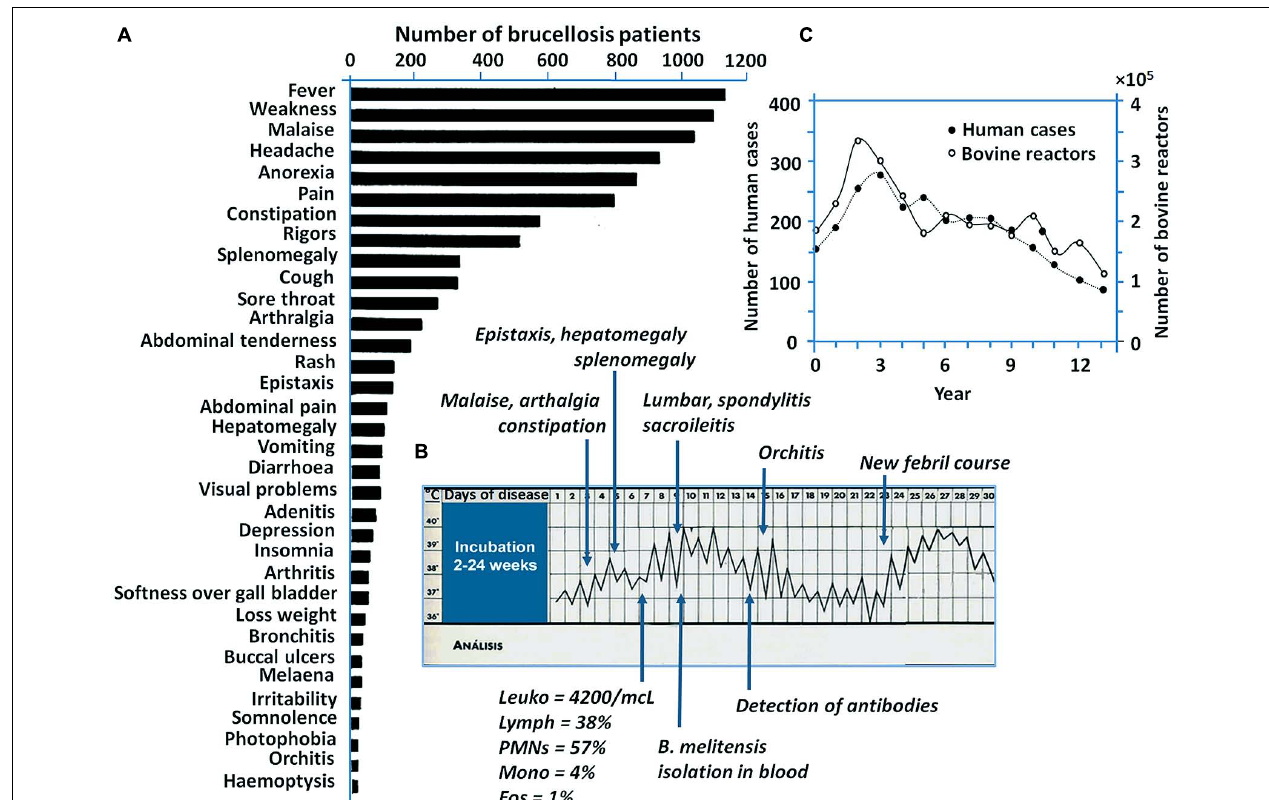
infections in United States during 13 year lapse period (1976–1986; adapted from Nicoletti, 1989). In contrast to the silent course of brucellosis in non-pregnant domestic animals, brucellosis in humans courses with a broad collection of clinical symptoms. Notice that the increase and decrease of human brucellosis cases roughly correlates with the increase or decrease of the infection in